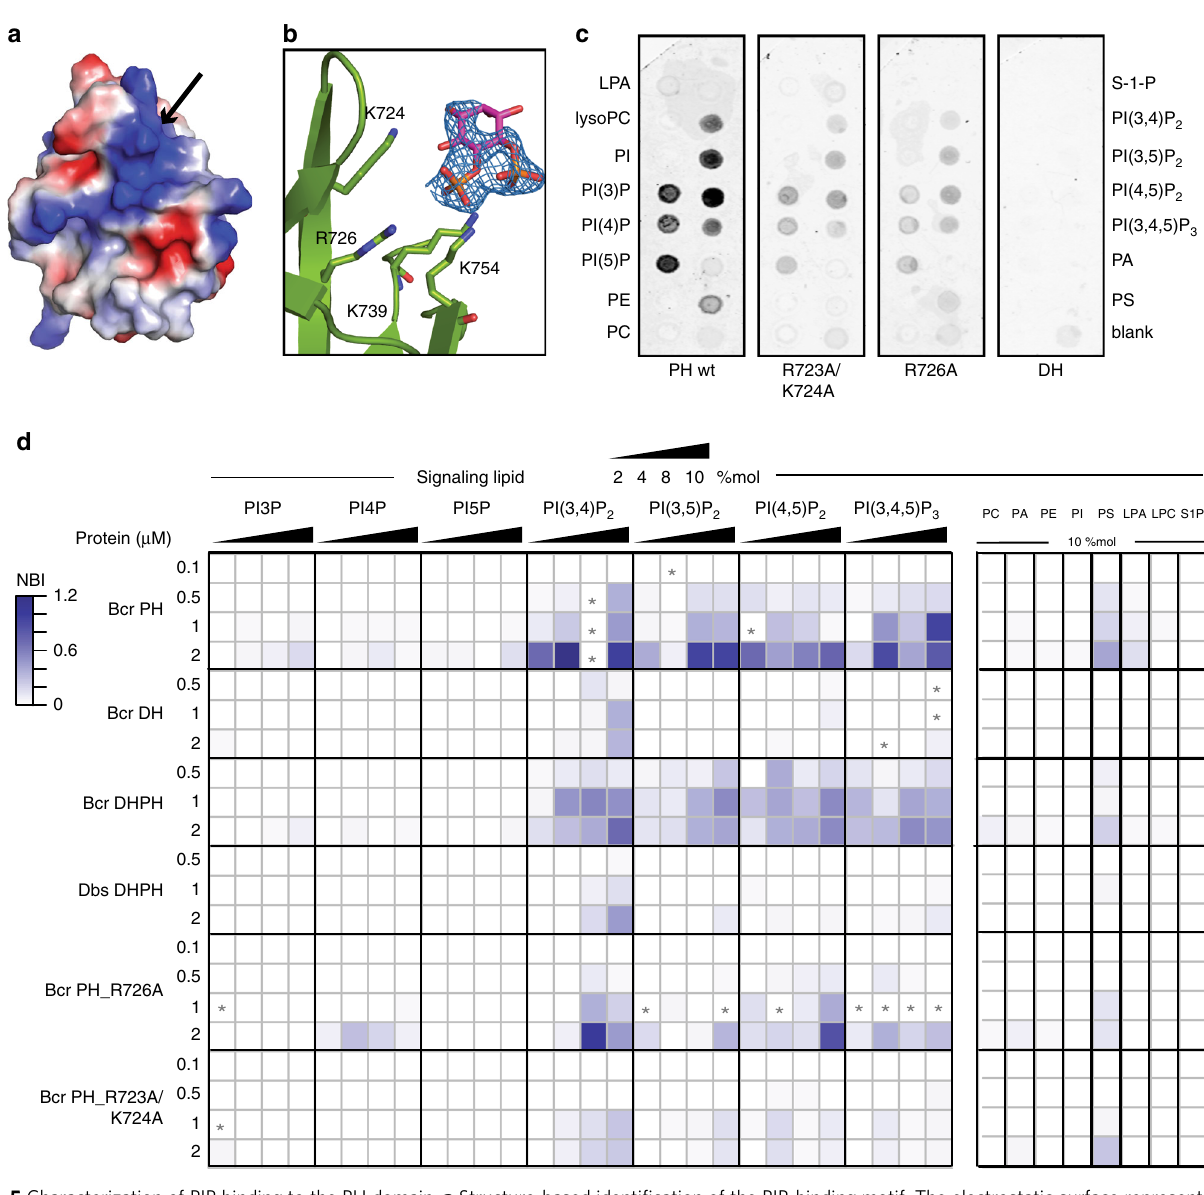
Fig. 5 Characterization of PIP binding to the PH domain. a Structure-based identi fi cation of the PIP-binding motif. The electrostatic surface representation indicates that the PIP-binding motif (black arrow) forms a positively charged patch on the PH surface. b The PIP-binding site is shown enlarged together with a D-myo-inositiol-4,5-bisphosphate (IP 2 ) ligand fi tted in the 2Fo – Fc electron-density map, contoured at 1.0 sigma. Critical residues in the binding motif are shown in sticks representation and colored by element. c PIP strips comparing the PIP-binding properties of PH wt, the PH R723A/K724A and R726A mutants, as well as the DH domain as a negative control. Individual signals on the strip were quanti fi ed relative to PH wild-type protein. d Binding of Bcr-Abl domains to surrogates of biological membranes in the liposome microarray (LiMA) assay. 0.1, 0.5, 1, and 2 μ M of puri fi ed sfGFP-tagged Bcr-Abl DH, PH, DH – PH or Dbs DH – PH domains were incubated together with giant unilamellar liposomes containing the indicated concentrations of signaling